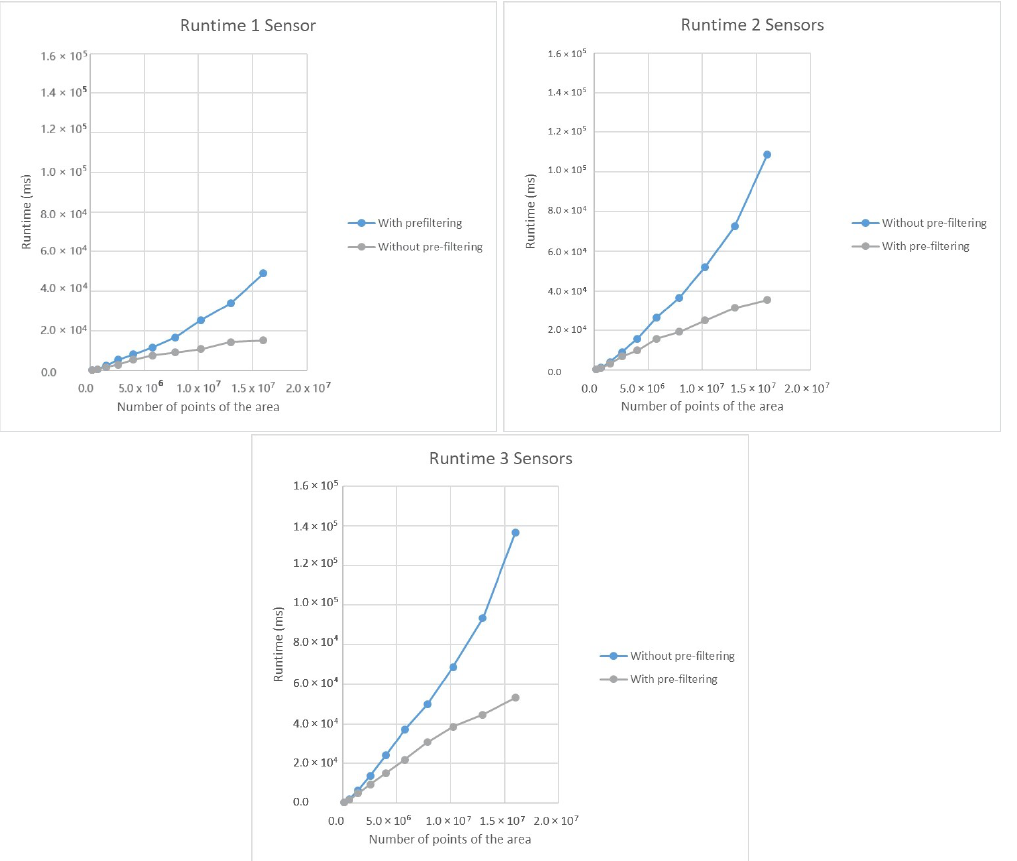
Figure 4. Evaluation of the runtimes with the different number of sensors according to the evaluated